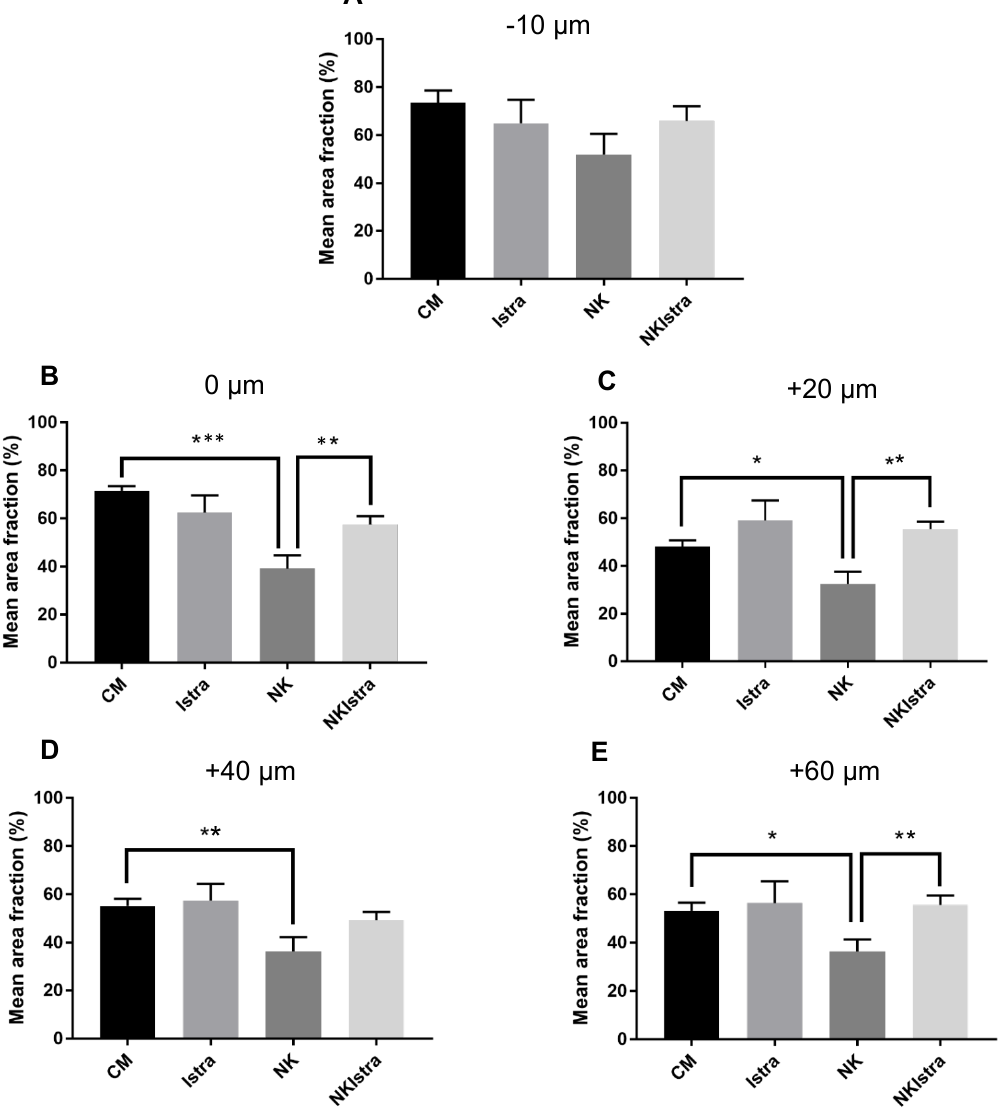
Figure 4. The relative density of SGN neurites in cochlear explants at di ff erent regions of interest designated as ( A ) − 10 µ m, ( B ) 0 µ m, ( C ) + 20 µ m, ( D ) + 40 µ m and ( E ) + 60 µ m. CM, normal culture medium (n = 7); Istra, istradefylline (n = 5); NMDA / kainic acid, NK (n = 7), NKIstra, NK + istradefylline (n = 10). Data presented as mean ± SEM. * p < 0.05; ** p < 0.01; *** p < 0.001, one-way ANOVA followed by a post-hoc Sidak’s multiple comparisons